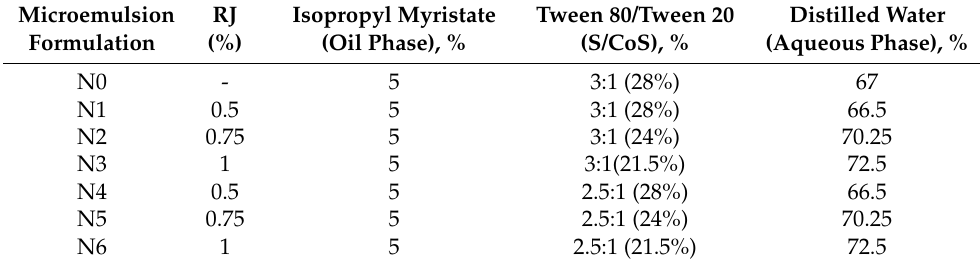
Table 2. Composition of microemulsion formulations containing